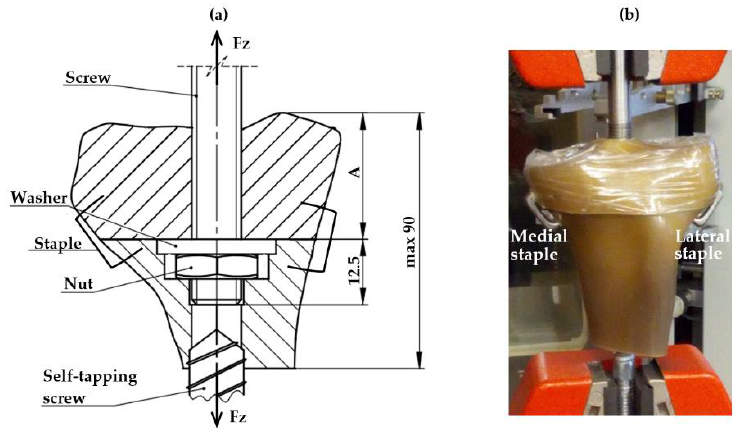
Figure 12. ( a ) A schematic drawing of the experiment (dimensions in mm); ( b ) Actual implementation of the experiment.